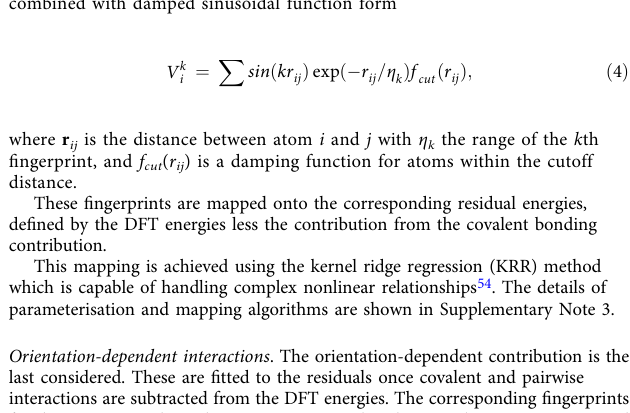
Supplementary Table 2. The fi delity of our HMLP is evaluated by the comparison of our ML prediction and the DFT calculations in Supplementary Fig. 6. The mean absolute error is of the order of the expected numerical and theoretical accuracy of the reference quantum mechanics-based calculations, indicating good performance of the present ML model.